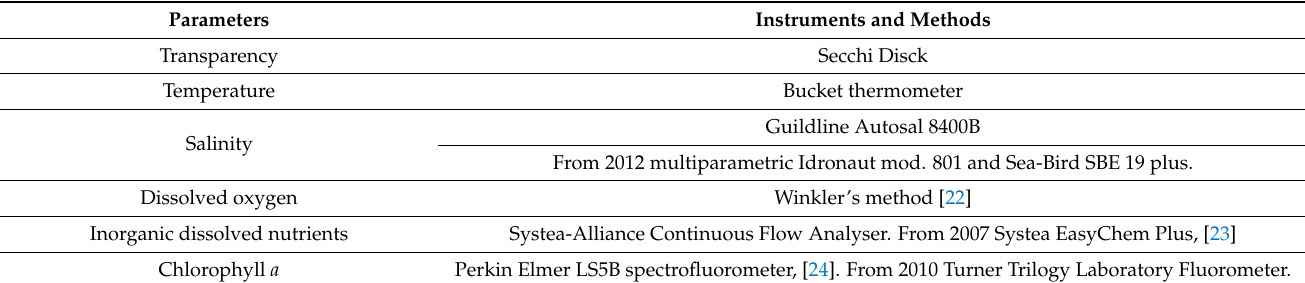
Table 1. Investigated parameters, instruments and